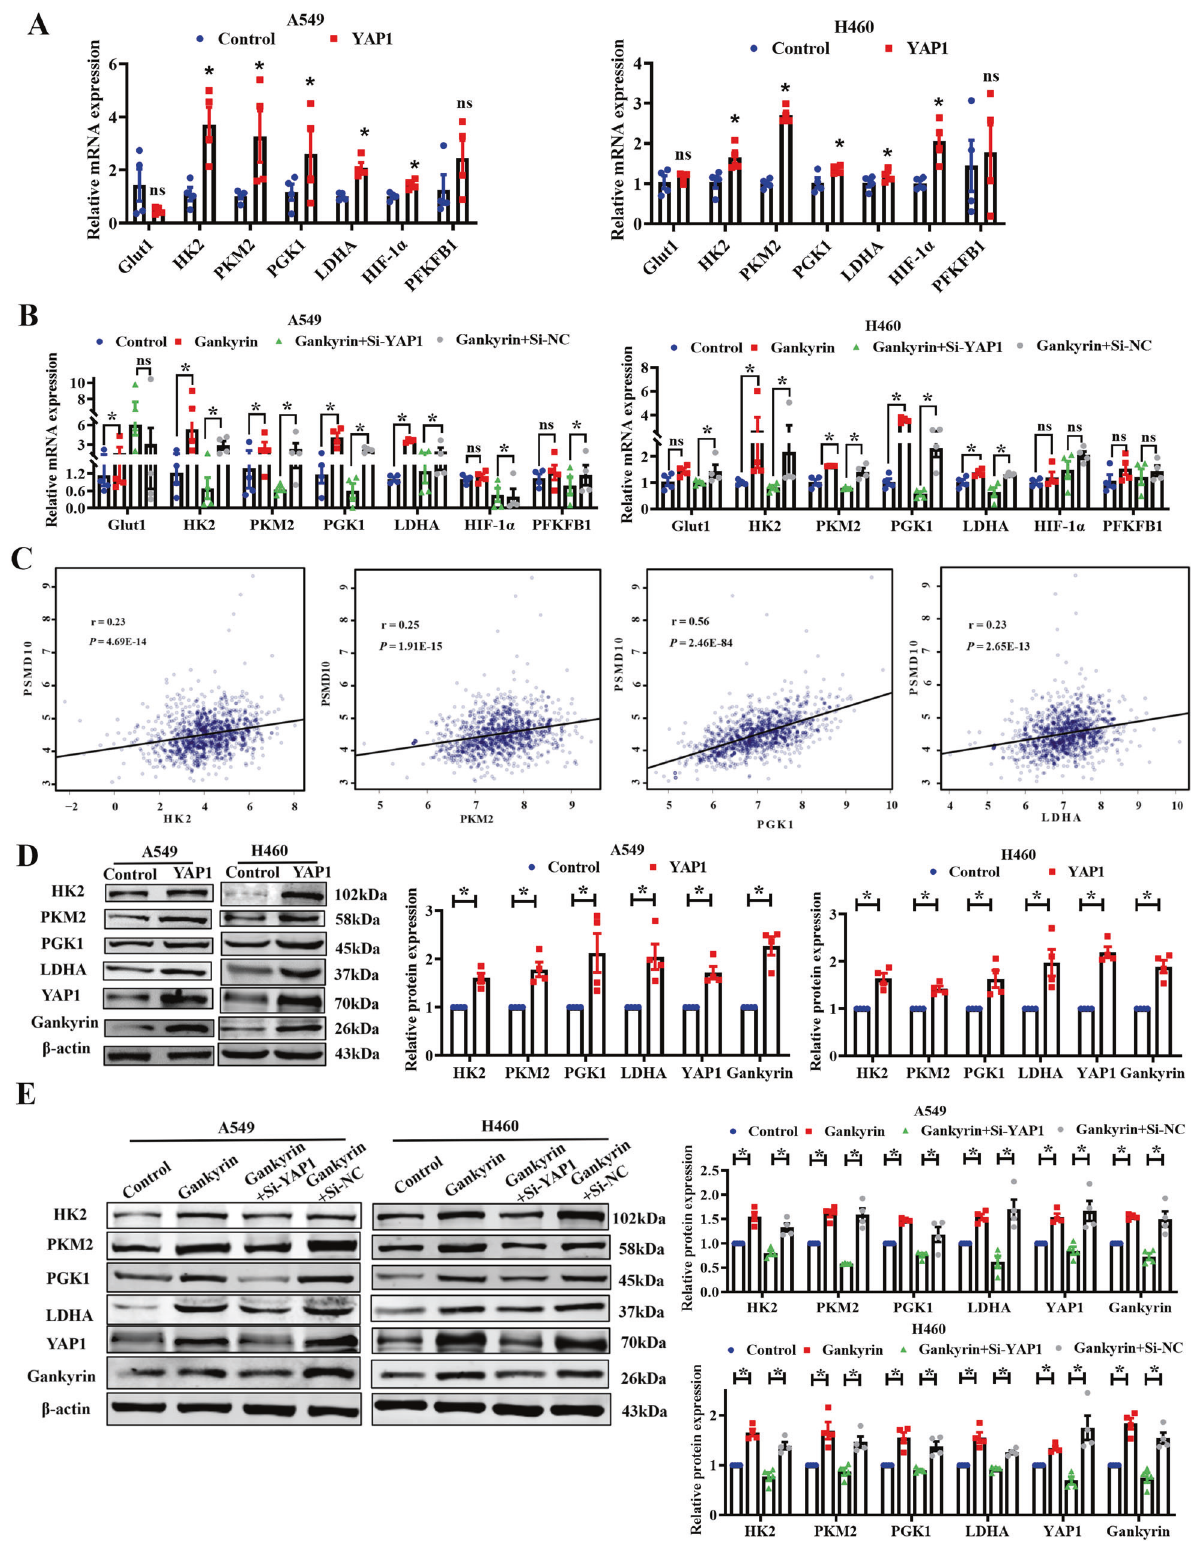
Fig. 7 Gankyrin regulates the key enzymes of glycolysis via YAP1 in NSCLC cells. A , B qRT-PCR assay results show the mRNA levels of glycolytic genes including Glut1 , HK2 , PKM2 , PGK1 , LDHA , HIF-1 α , and PFKFB1 in A549 and H460 cells ( n = 4, * P < 0.05, ns means no signi fi cant). C Correlation between expression of PSMD10 and the glycolytic genes HK2, LDHA, PGK1, and PKM2 in TCGA dataset. D , E Western blotting results show the protein level of key glycolysis enzymes, including HK2, PKM2, PGK1, and LDHA in A549 and H460 cells ( n = 4, * P < 0.05).